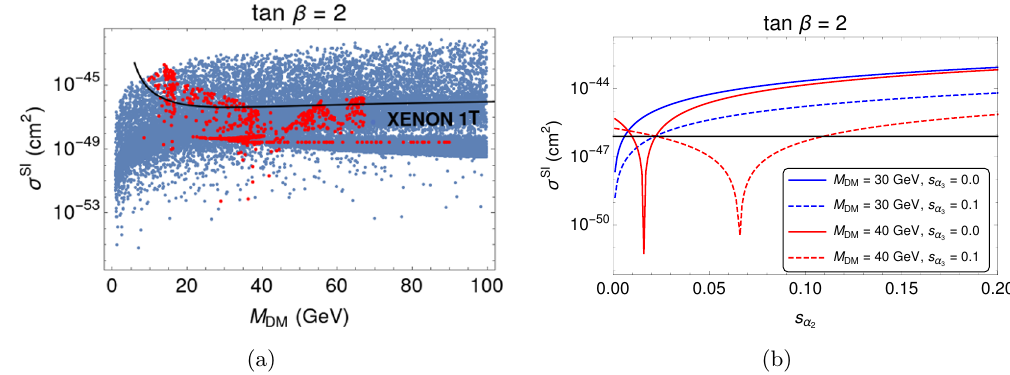
Figure 9 . (a) The allowed regions of the DM mass satisfying the bounds on relic density and the spin-independent direct detection cross section ( σ SI ) of DM from XENON 1T, please see the text for other details. The allowed DM masses near M Z 0 / 2 are not shown in this plot. (b) Dependencies of σ SI on s α and s α within the allowed ranges of M DM 2 3